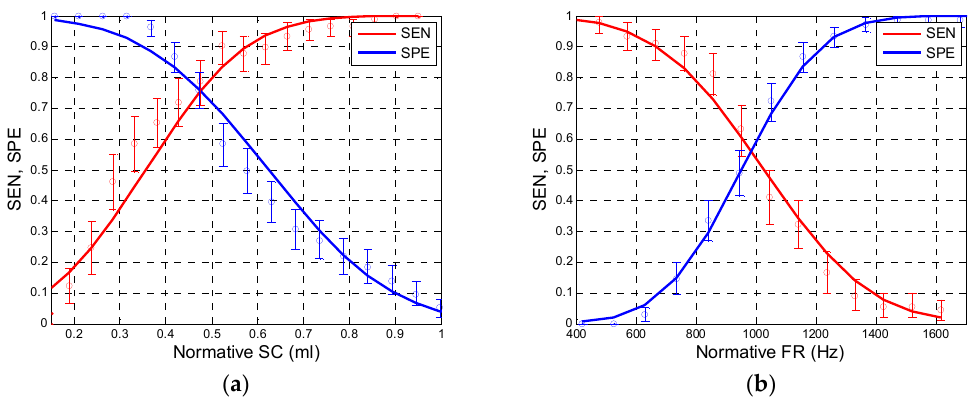
Figure 10. Sensitivity (SEN, red) and specificity (SPE, blue) of tests based on static compliance (SC) ( a ) and resonance frequency (FR) ( b ) as test criteria. Lines show approximations to normal distribution functions (based on data from Figure 5). Whiskers denote 5 – 95% confidence intervals. As these figures show, the courses of the sensitivity and specificity functions differ depending on the applied test criterion. The best performance of test is achieved at the intersection point of